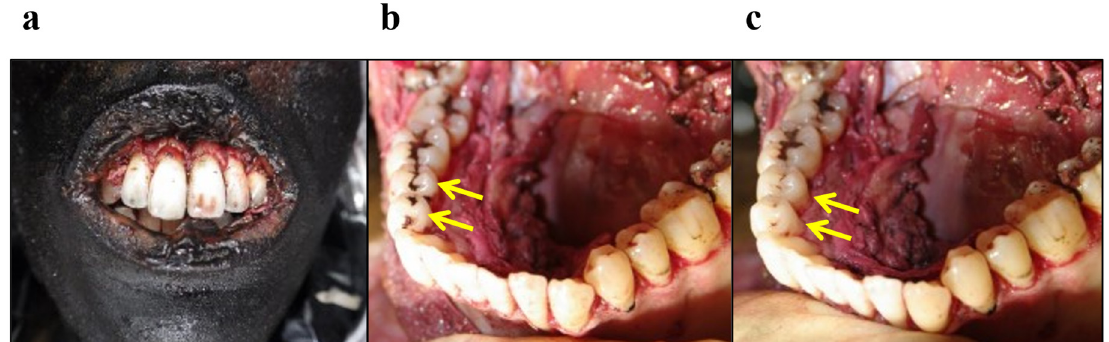
Figure 3. Misidentification of residual soot remaining in a fissure as metal fillings. ( a ) The frontal view before autopsy. Before imaging, opening the mouth and removing the lips were attempted in vain. ( b ) The mandibular occlusal surface view after autopsy. Presumed metal filling-like findings are visible and confirmed in a fissure on the occlusal surface of the mandibular right first and second premolars (arrows). This finding is not metal fillings and was ultimately identified as soot. ( c ) The mandibular occlusion view after autopsy and repeated oral cleanings. Soot in a fissure on the occlusal surface of the mandibular right first and second premolars has been removed (arrows).